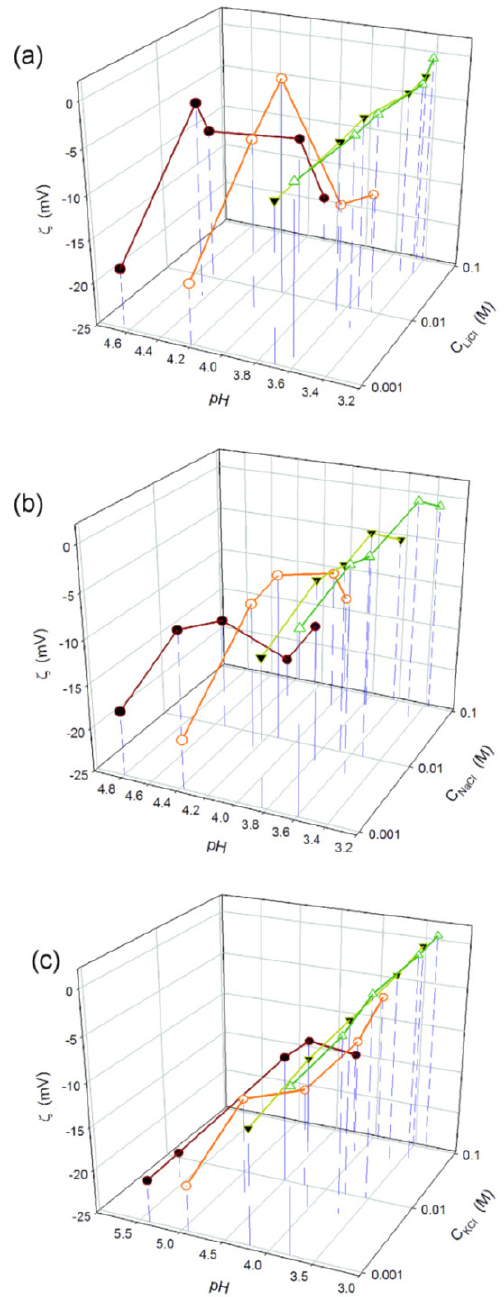
Figure 5. Zeta potential as a function of pH and salt content for (a) LiCl, (b) NaCl, and (c) KCl at different content of A-200 in the suspensions: 0.5 ( ), 1 ( ), 2.5 ( ), and 5 ( ) wt.%. at. Therefore the subsequent calculations were carried out using the zeta potentials calculated using the Smoluchowski equation. For the more complex nanoparticles, such as nanocarbon-nanosilica or mixed oxides, the difference in the zeta potentials calculated